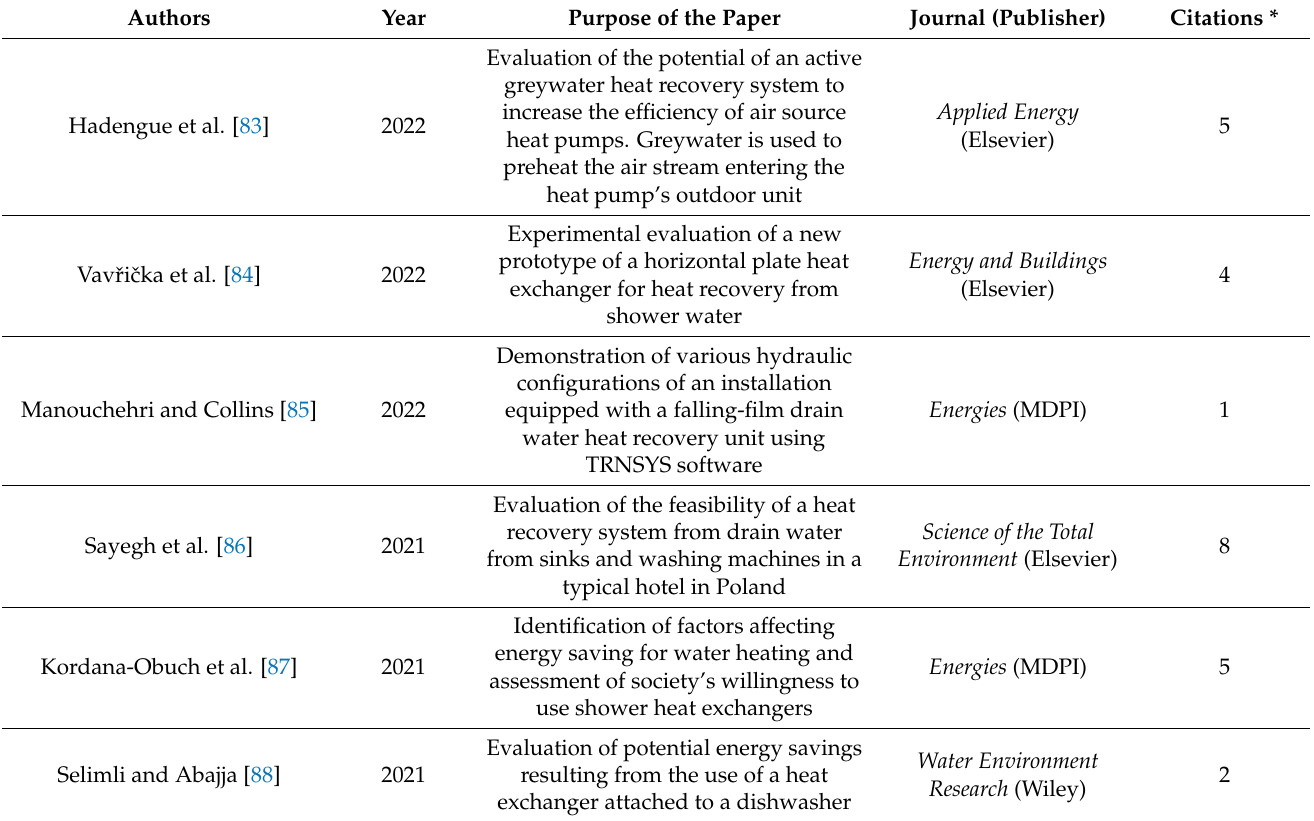
Figure 2. Publication trend in greywater energy recovery domain. Table 4. Selected research papers from the last five years in greywater energy recovery domain.